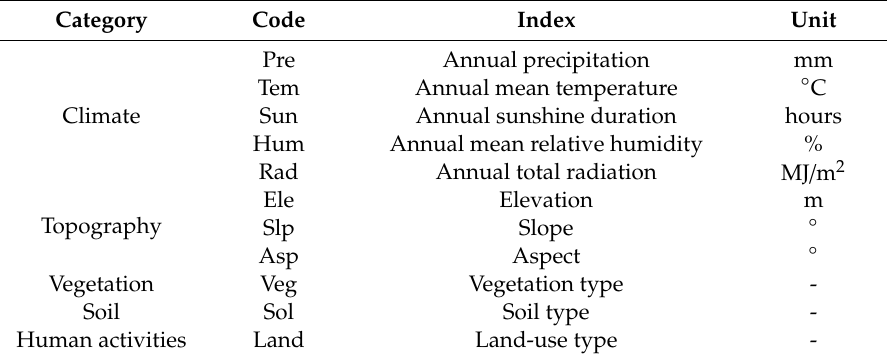
Table 1. The name and introduction of